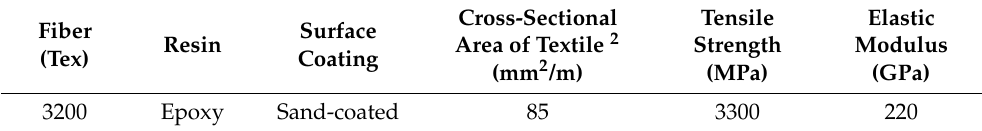
Table 7. Material properties of carbon textile grid (suggested values by the manufacturer 1 ).